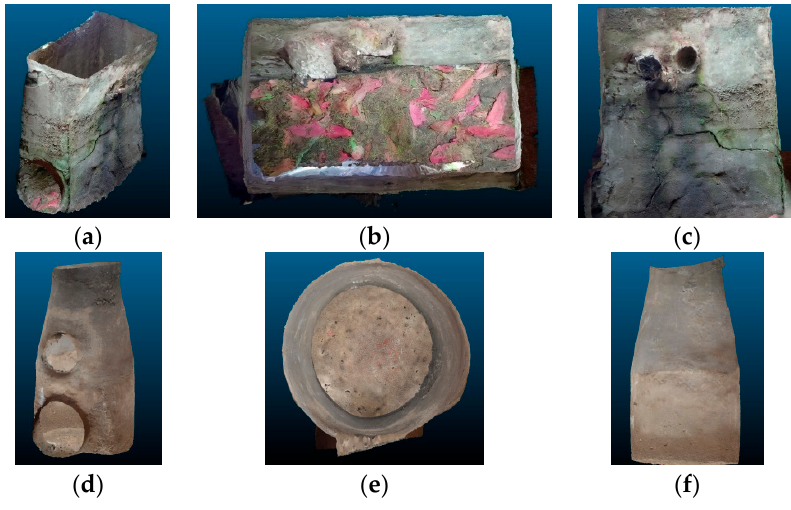
Figure 12. Reconstruction results of scene 3 ( a – c ) and scene 4 ( d – f ).